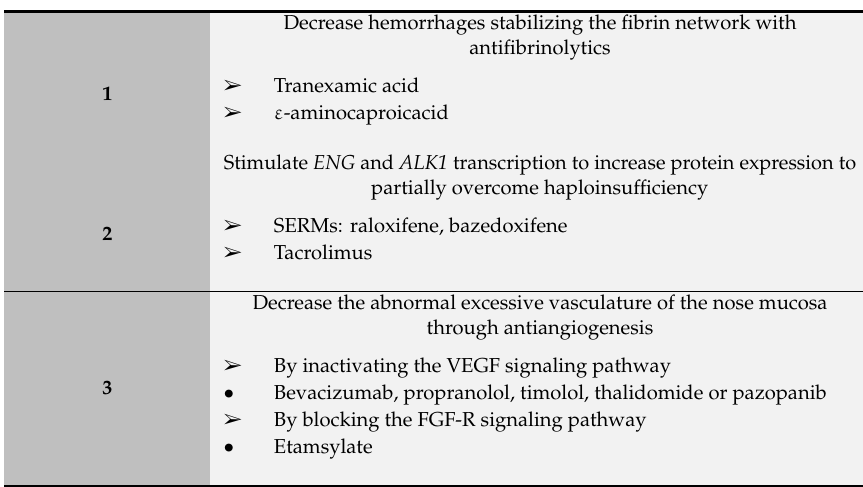
Table 1. Therapeutic strategies to decrease epistaxis in